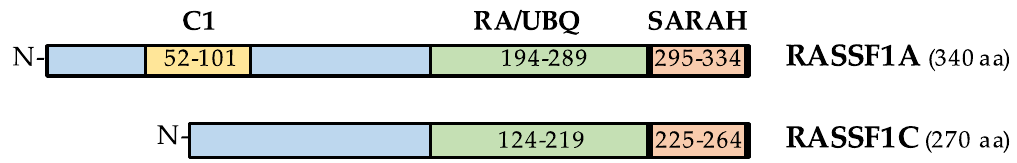
Figure 2. Protein domains of RASSF1A and RASSF1C. RASSF1A is a 340 amino acid (aa) long protein with a protein kinase C conserved region (C1), Ras association/ubiquitin-like (RA/UBQ) domain and Sav/Rassf/Hpo (SARAH) domain. RASSF1C is a 270 aa long protein and encodes a RA/UBQ and a SARAH domain.